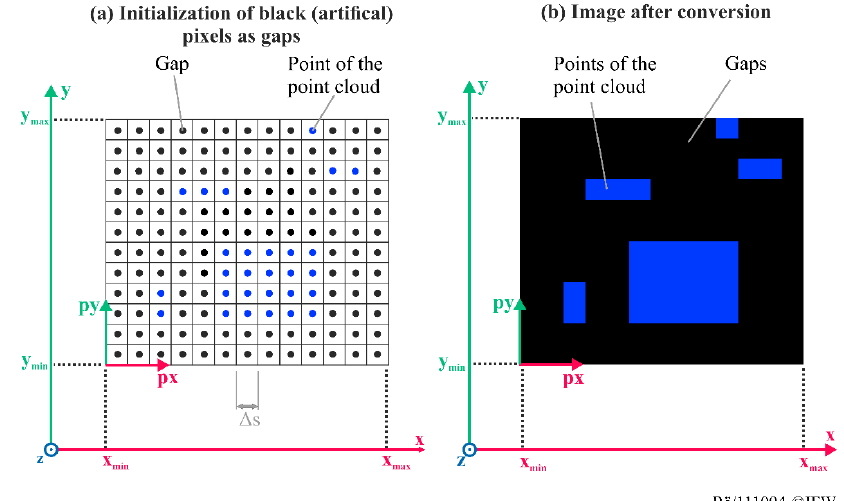
Figure 8. ( a , b ) Image conversion of a point cloud.